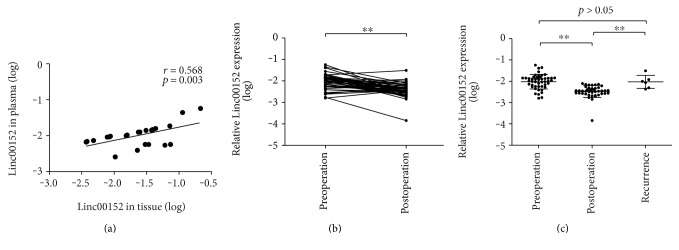
Dynamic monitoring of plasma Linc00152 levels in NSCLC patients. (a) Correlation of Linc00152 expression levels in tumor and plasma samples. (b) Comparison of plasma Linc00152 levels between pre- and postoperative samples. (c) Scatter plots of plasma Linc00152 levels from preoperative, postoperative, and recurrent patients, ∗∗P < 0.001.